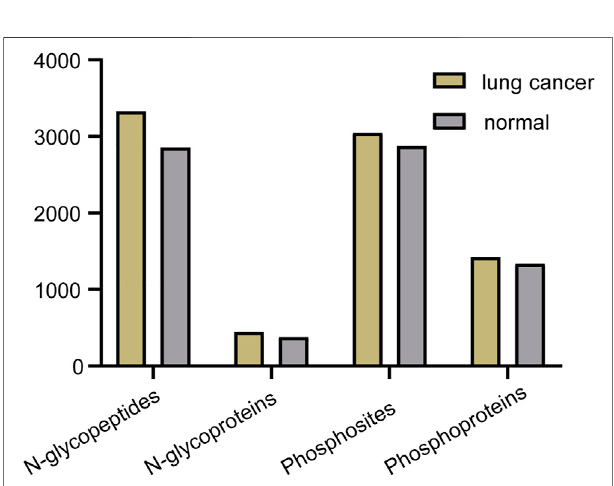
FIGURE7| NumberofN-glycopeptides,N-glycoproteins,phosphosites and phosphoproteins identi fi ed in three replicates in lung cancer and normal